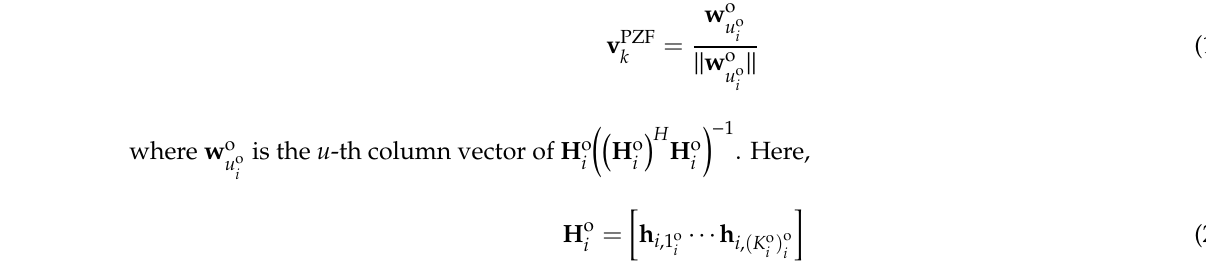
Figure 1. Behavior of parameterized beamforming (PB) according to parameter θ